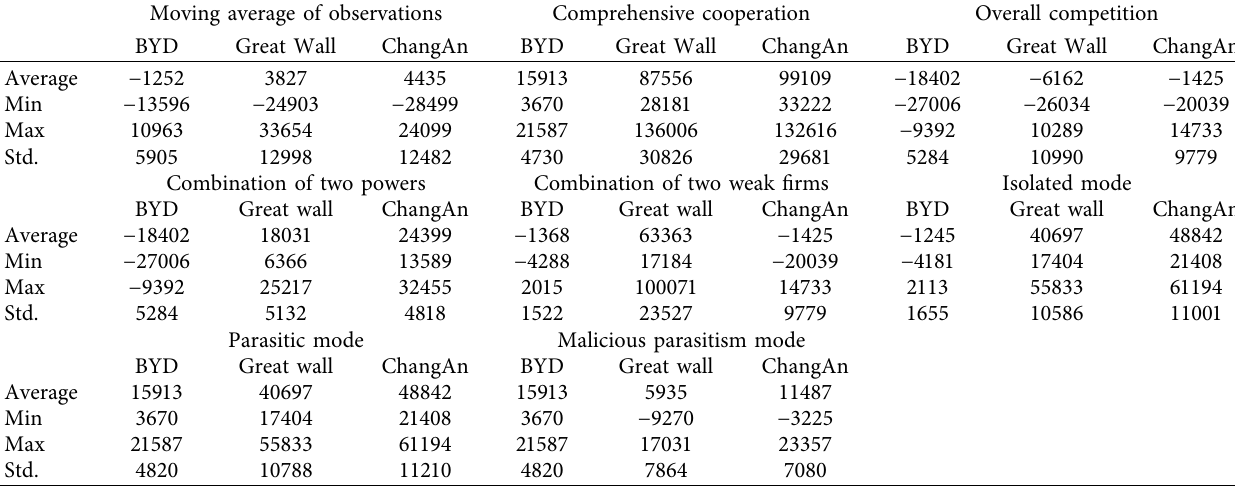
Table 8: Statistical characteristics of population